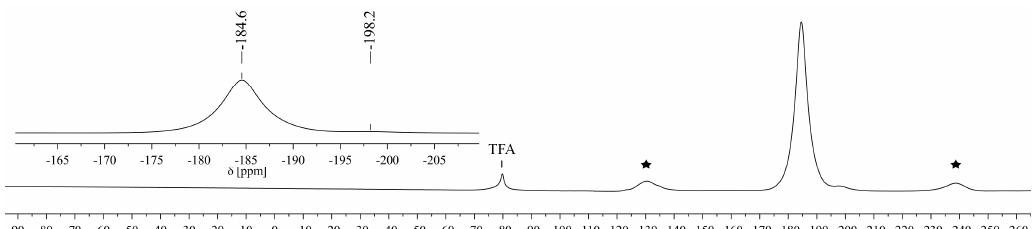
Figure 4. 19 F MAS NMR of non-annealed xerogel 12 , star: rotational side band, υ rot = 20 kHz.